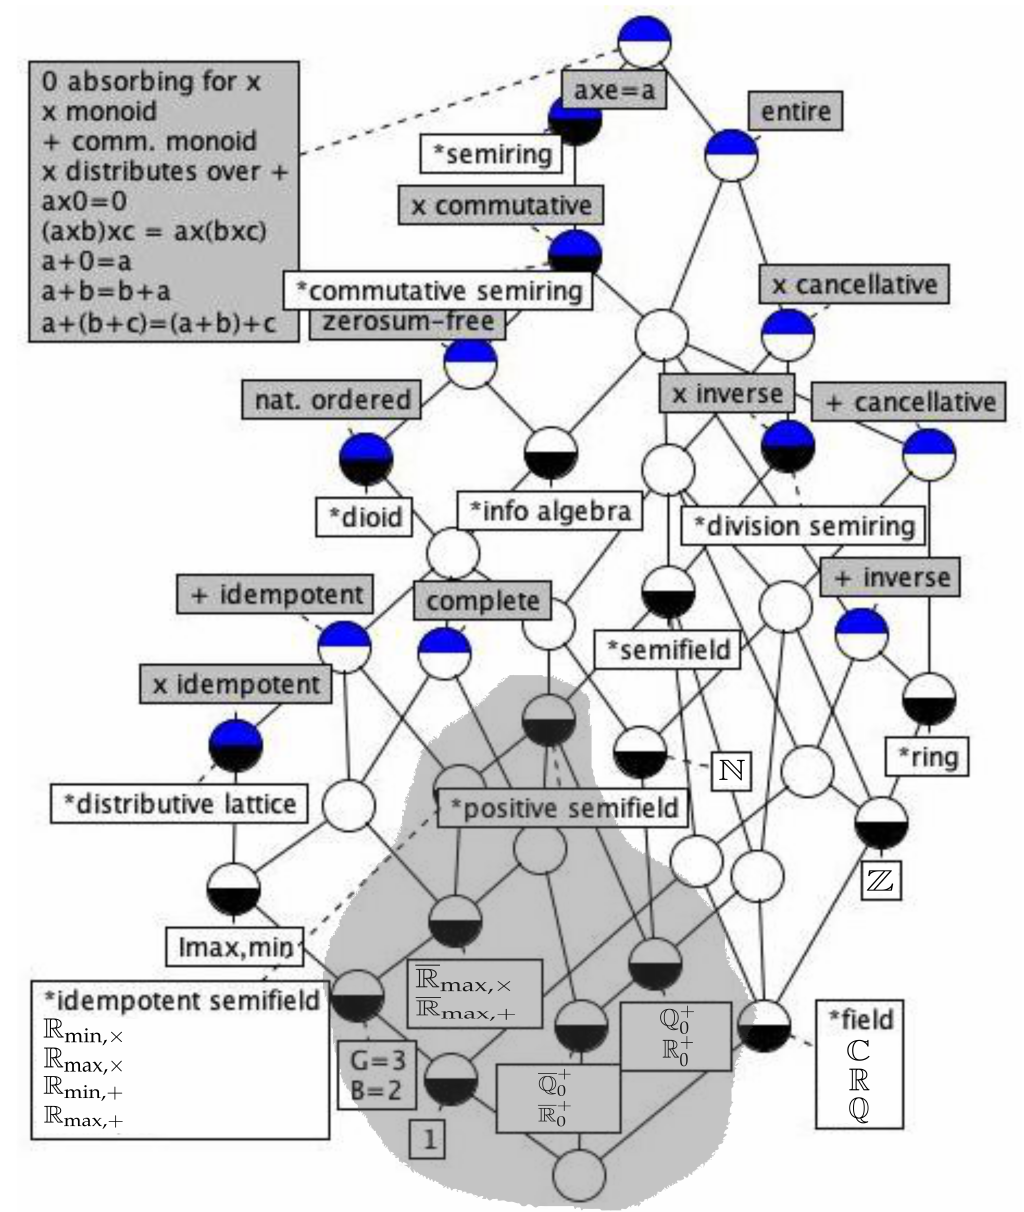
Figure 1. Lattice of a selection of abstract (leading asterisk, white label) and concrete (white label) commutative semirings and their properties (grey label) mentioned in the text, adapted from [9]. Each node is a concept of Abstract Algebra: its properties are obtained from the gray labels in nodes upwards, and its structures from the white labels in nodes downwards. The picture is related to the chosen sets of properties and algebras and does not fully reflect the structure of the class of semirings. We have chosen to highlight idempotent and non-idempotent positive semifields, such as R +